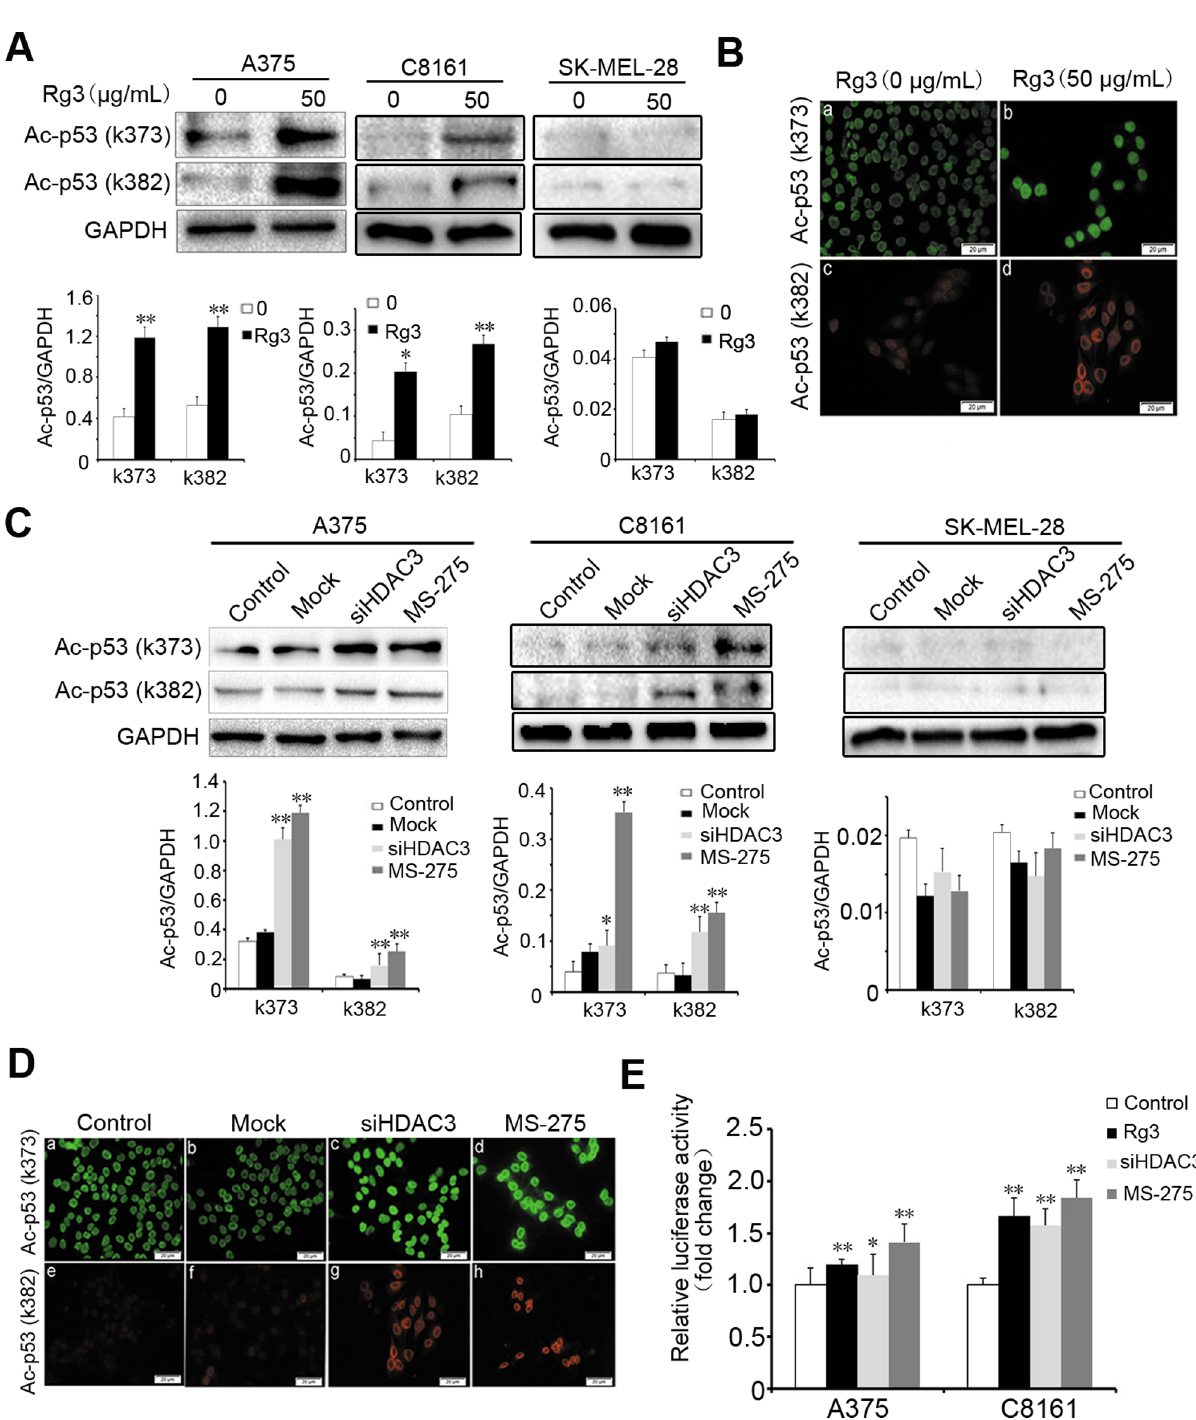
Fig. 5. Rg3 and down-regulating HDAC3 expression increase p53 acetylation and transcription activity. Cells were treated with Rg3 (0, 50 m g/mL) for 24 h. (A) Western blotting analysis of the expression levels of Ac-p53 (k373/382) in A375, C8161 and SK-MEL-28 cells. (B) Immunofluorescent staining analysis of expression levels of Ac-p53 (k373/382) in A375 cells. Cells were transfected with HDAC3 siRNA (48 h) or exposed to MS-275 (10 m M) for 24 h. (C) Western blotting analysis the expression levels of Ac-p53 (k373/382) in A375, C8161 and SK-MEL-28 cells. (D) Immunofluorescent staining analysis the expression levels of Ac-p53 (k373/382) in A375 cells. Control: untransfected cells; Mock: cells transfected with vector; siHDAC3: cells transfected with